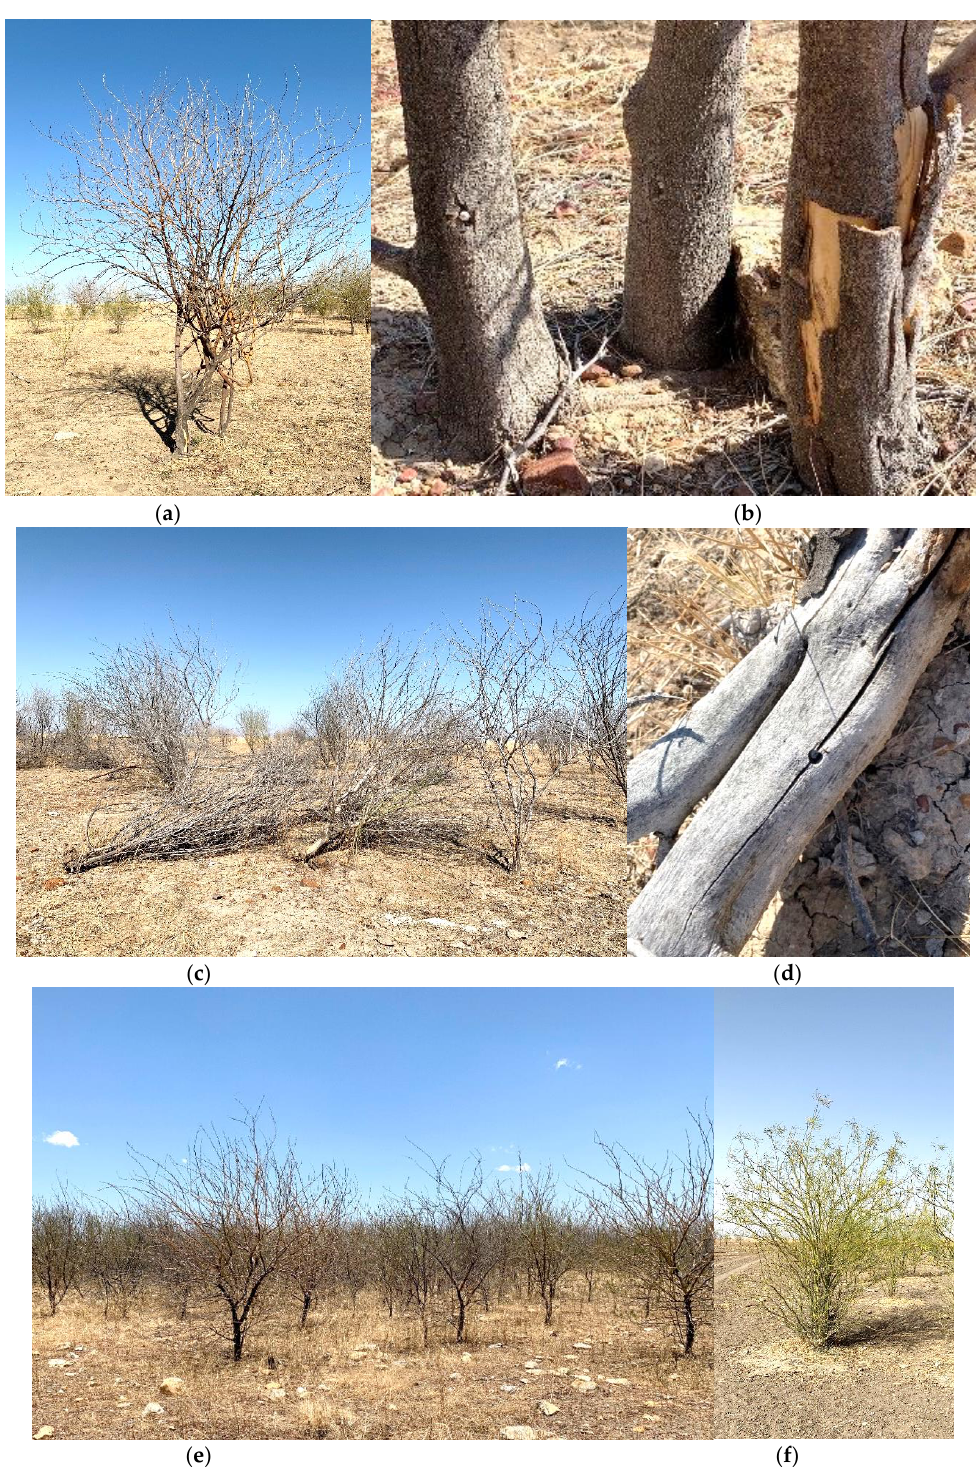
Figure 3. North parkinsonia infestation mortality over trial duration (0, 45, 64, 165 and 221 WAT). Treated plants (gold), untreated control plants (green). Error bars represent ± standard error of means.